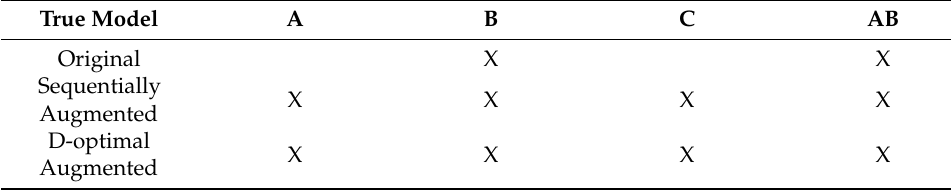
Table 5. Significant terms detected by each design.